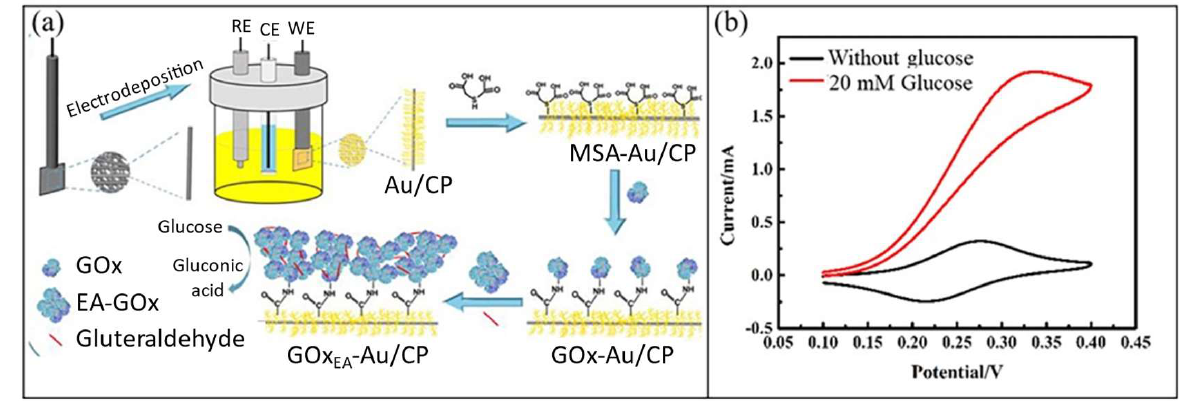
Figure 9. ( a ) Schematic of the fabrication process of the GOx/3D Au coral/carbon paper − modified electrode, ( b ) CV of the GOx/3D Au coral/carbon paper − modified electrode in PBS solution (pH 7) containing ferrocene as redox mediator without glucose and with 20 mM glucose. Reprinted with permission from ref. [140]; Copyright 2020 Elsevier.